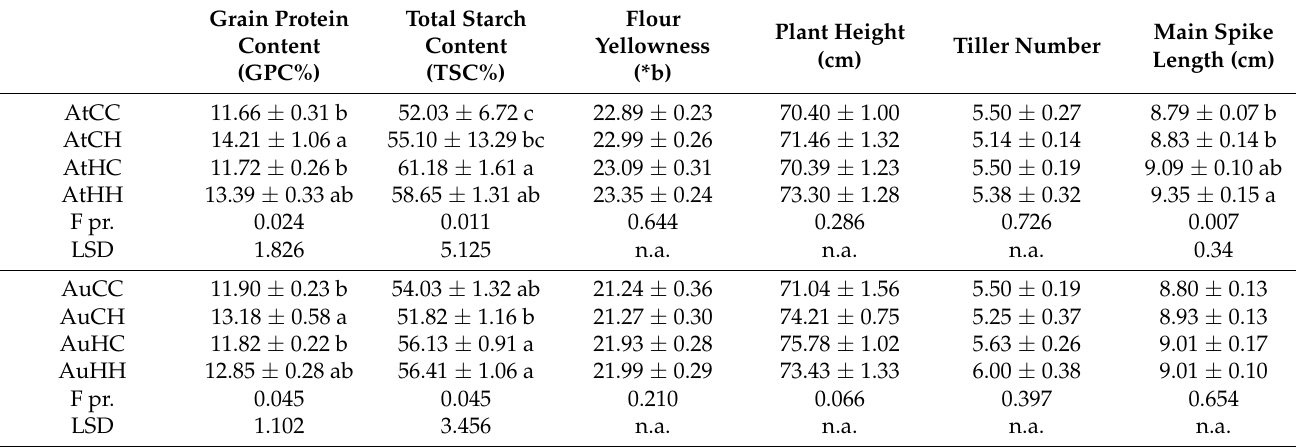
Table 2. Progeny grain quality and morphological performance under the effects of transgenerational and progeny heat stress. Means are shown with standard error ( n = 8 for morphological traits, n = 8 for grain quality traits). The letters (a, b, c) indicate significant statistical difference ( p < 0.05) across treatment groups within each variety. The treatment groups are: AuCC (DBA Aurora progeny treated with the control, originated from control group parents), AuCH (DBA Aurora progeny treated with heat stress, originated from control group parents), AuHC (DBA Aurora progeny treated with the control, originated from heat stress group parents), AuHH (DBA Aurora progeny treated with heat stress, originated from heat stress group parents), AtCC (DBA Artemis progeny treated with the control, originated from control group parents), AtCH (DBA Artemis progeny treated with heat stress, originated from control group parents), AtHC (DBA Artemis progeny treated with the control, originated from heat stress group parents), AtHH (DBA Artemis progeny treated with heat stress, originated from heat stress group